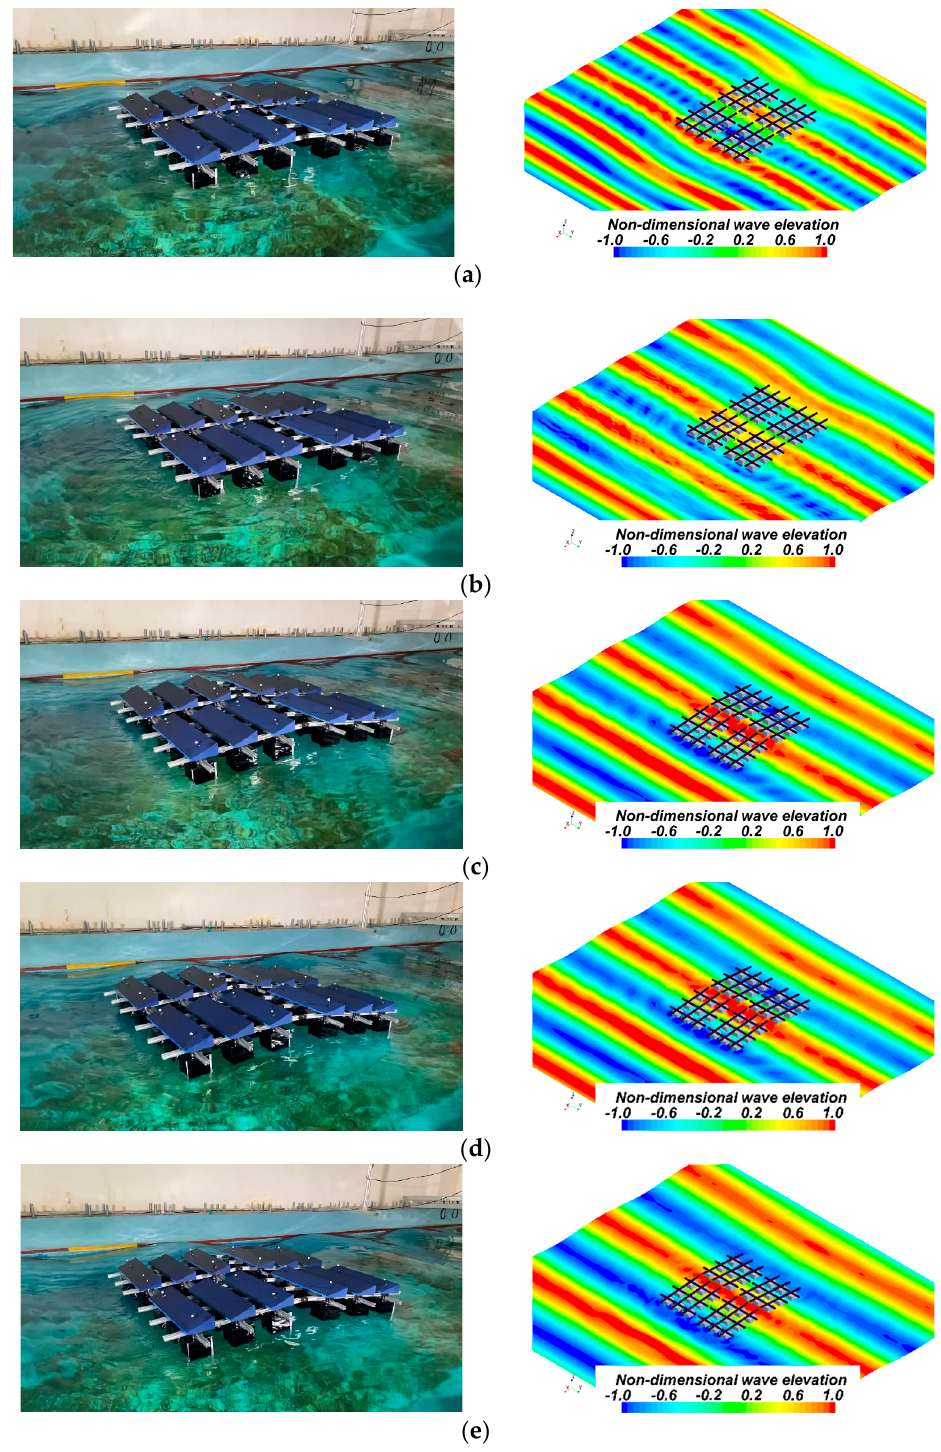
Figure 15. Wave pattern of experiment ( left ) and computation ( right ) according to the wavelength for 𝑯/𝝀 = 0.03 under head sea: ( a ) 𝝀/𝑳 𝒖𝒏𝒊𝒕 = 1.6; ( b ) 𝝀/𝑳 𝒖𝒏𝒊𝒕 = 2.0; ( c ) 𝝀/𝑳 𝒖𝒏𝒊𝒕 = 2.4; ( d ) 𝝀/𝑳 𝒖𝒏𝒊𝒕 = 2.8; ( e ) 𝝀/𝑳 𝒖𝒏𝒊𝒕 = 3.2.